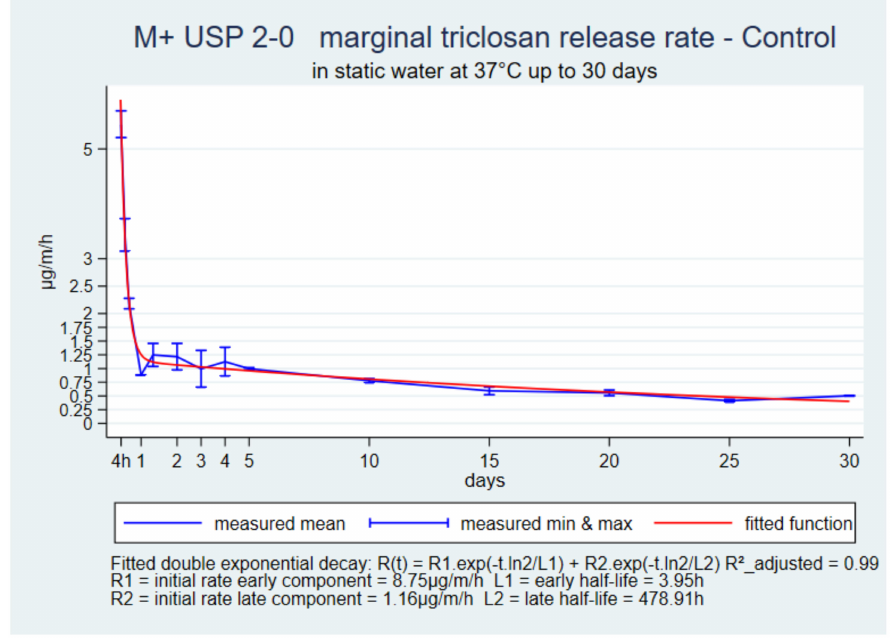
Figure 3. M+ USP 2-0, marginal release rate in static water up to 30